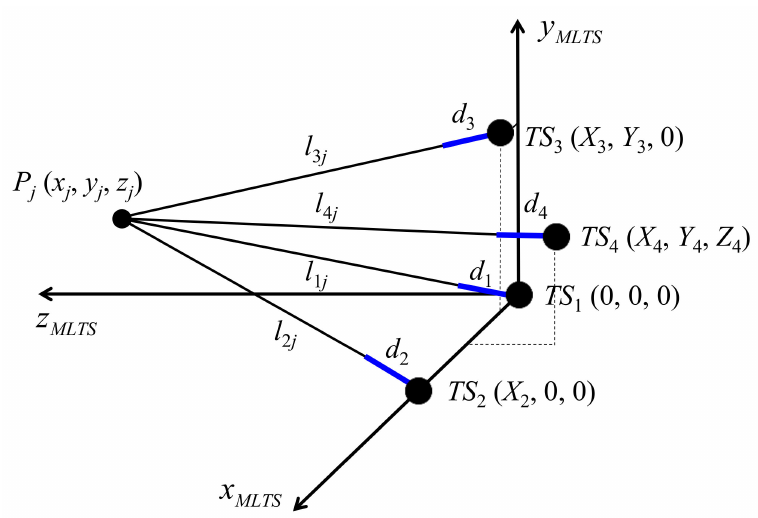
Figure 2. Schematic of the proposed self-calibration method for a multilateration tracking system using absolute distance